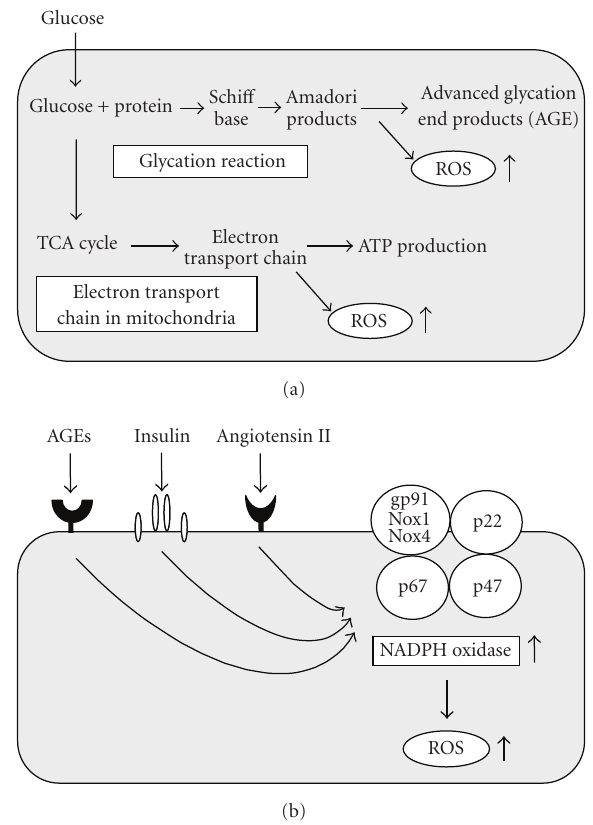
Figure 1: Augmentation of ROS by various pathways under diabetic conditions. (a) ROS are produced by various pathways under diabetic conditions. Hyperglycemia induces ROS through activa- tion of the glycation reaction and electron transport chain in mitochondria. (b) AGEs, insulin, and angiotensin II induces ROS through activation of membrane-bound NADPH oxidase.